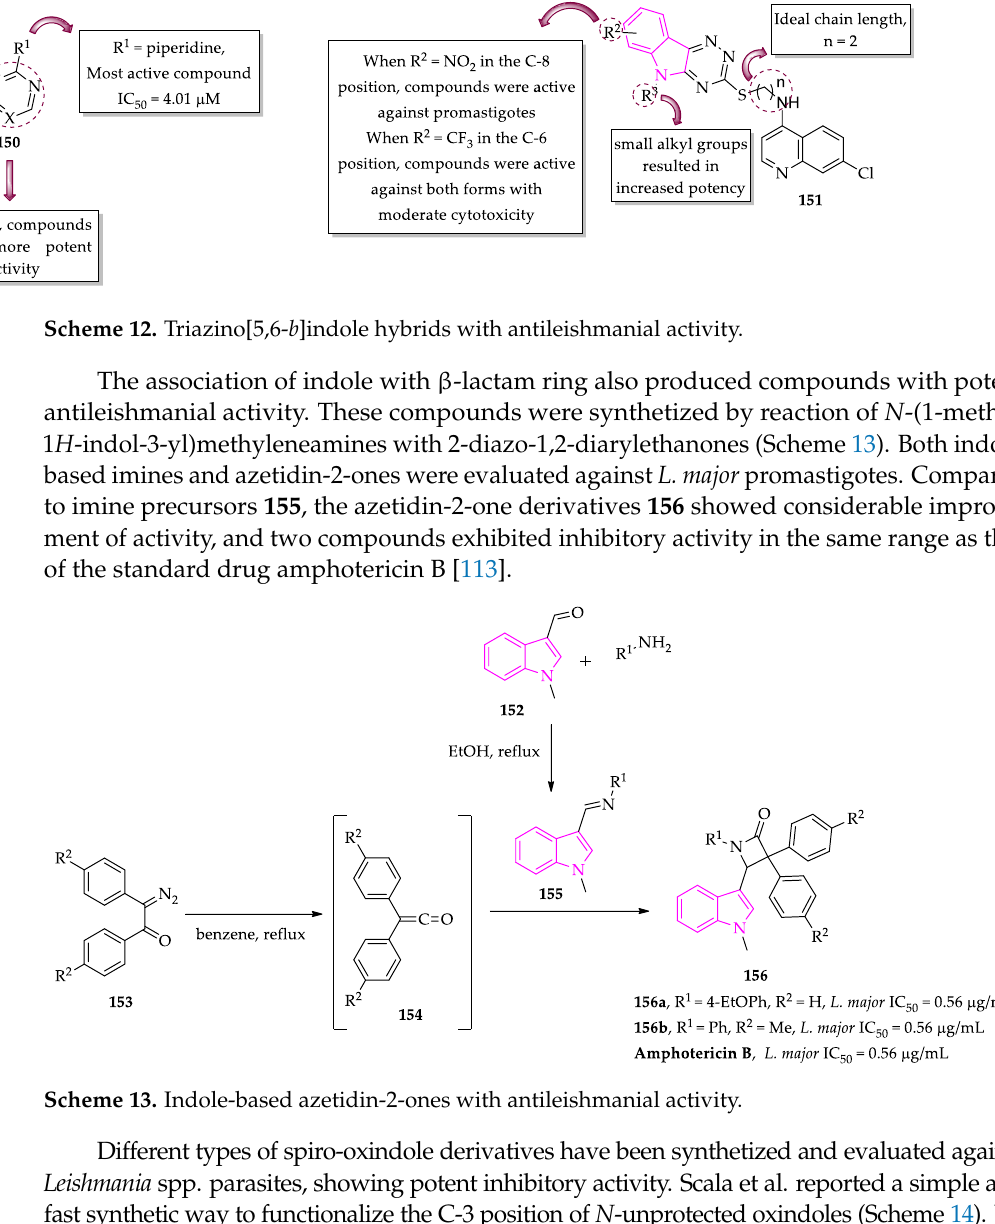
Scheme 14. Synthesis of C-3-mono-functionalized N -unprotected indolin-2-ones. Reinforcing the antiparasitic potential of this class of compounds, a small library of spirooxindoles and bis-spirooxindoles was screened against L. donovani topoisomerase IB